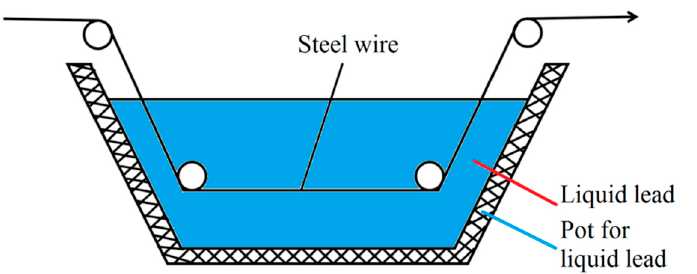
Figure 13. Schematic diagram of the lead bath quenching of steel wire. Reprinted with permission from ref. [22].